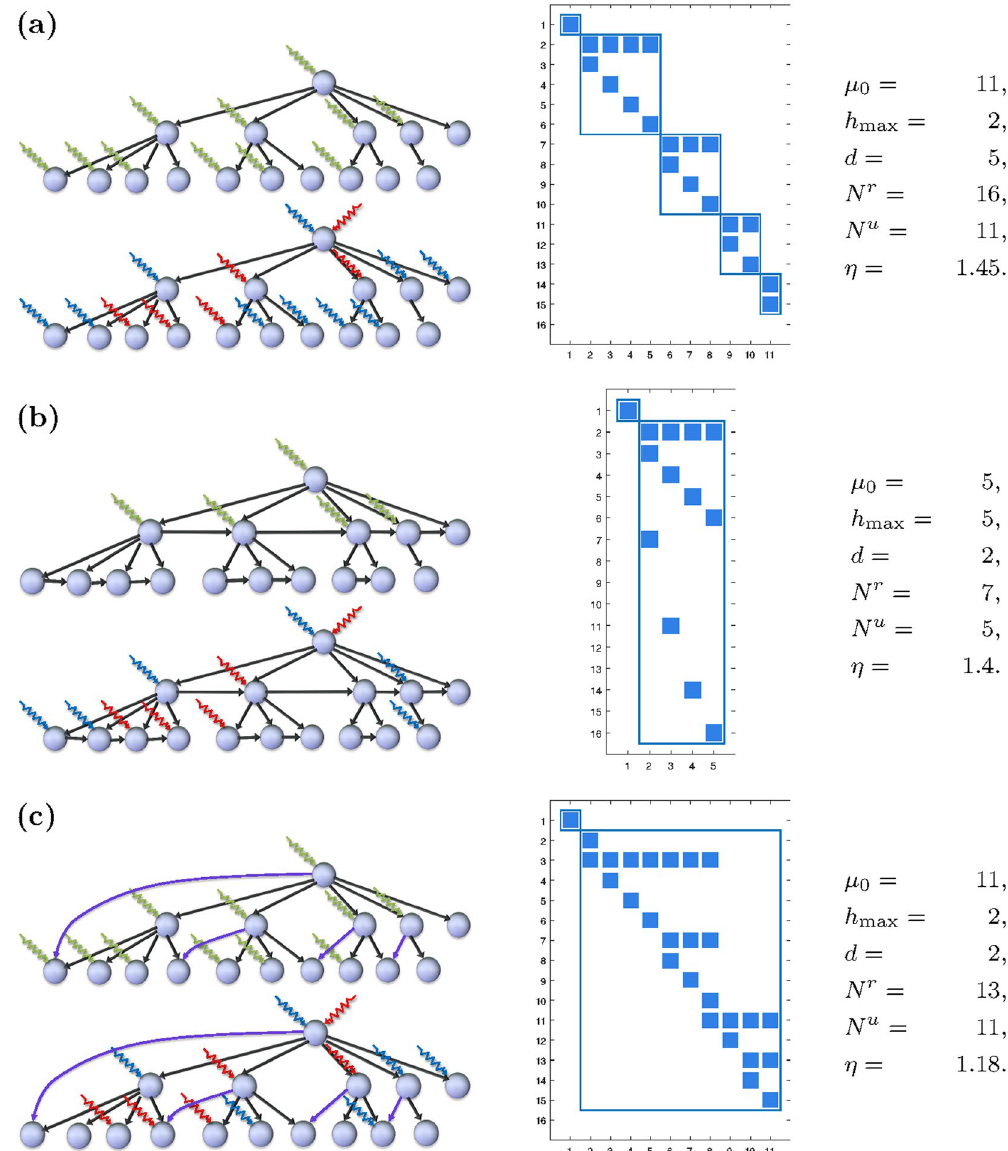
Figure 3. Rooted directed trees and directed acyclic graphs. ( a ) A RDT with 16 nodes of which 4 have outdegree ≥ 2 and 11 are leaves. For such tree it holds that N u = μ 0 = n leaf , and a minimal set of unrestricted inputs is indicated in the left panel (green arrows). To the right is a sparse plot of V 0 . The columns of V 0 form a basis for   A ( ) . Each node with outdegree ≥ 2 is a separate dilation, and the null space is the union of d = 5 structurally disjoint subspaces that are associated to the root and the dilations. A minimal set of unilateral controls is indicated in the left panel (red and blue arrows). For a RDT, N r does not depend on the numerical values of the edge weights, but the signs of the controls do. ( b ) Edges are added between nodes on the same layer. The tree structure is lost and the network is a DAG. By adding edges this way, longer paths are created. The depth h max is increased and μ 0 is reduced. Both N r and N u are reduced. ( c ) Descending edges are added to the original RDT. Neither h max nor μ 0 is altered and N u is unchanged. However, d is reduced and the lower bound N r ≥ μ 0 + d is